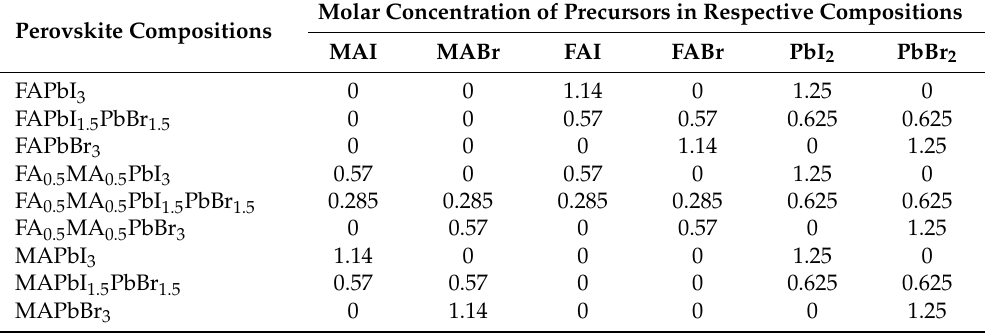
Table 1. Molar concentrations of the precursors in the perovskite precursor solution of each composition. Molar Concentration of Precursors in Respective Compositions Perovskite Compositions